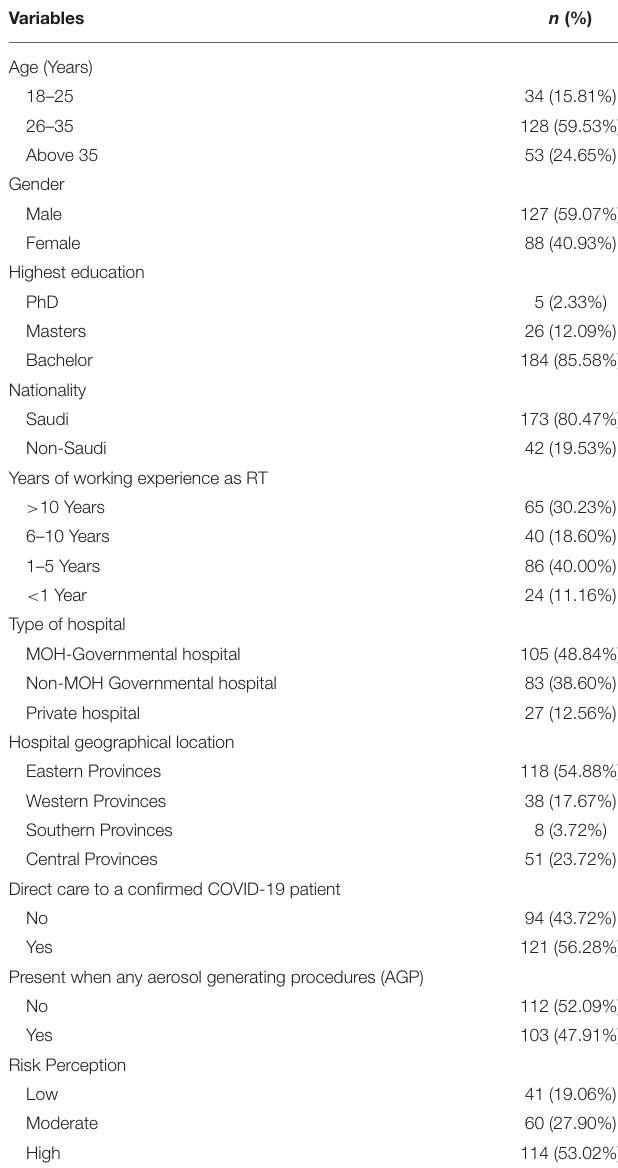
TABLE 3 | Socio-demographic characteristics, and risk perception to COVID-19 of the study participants ( N = 215).